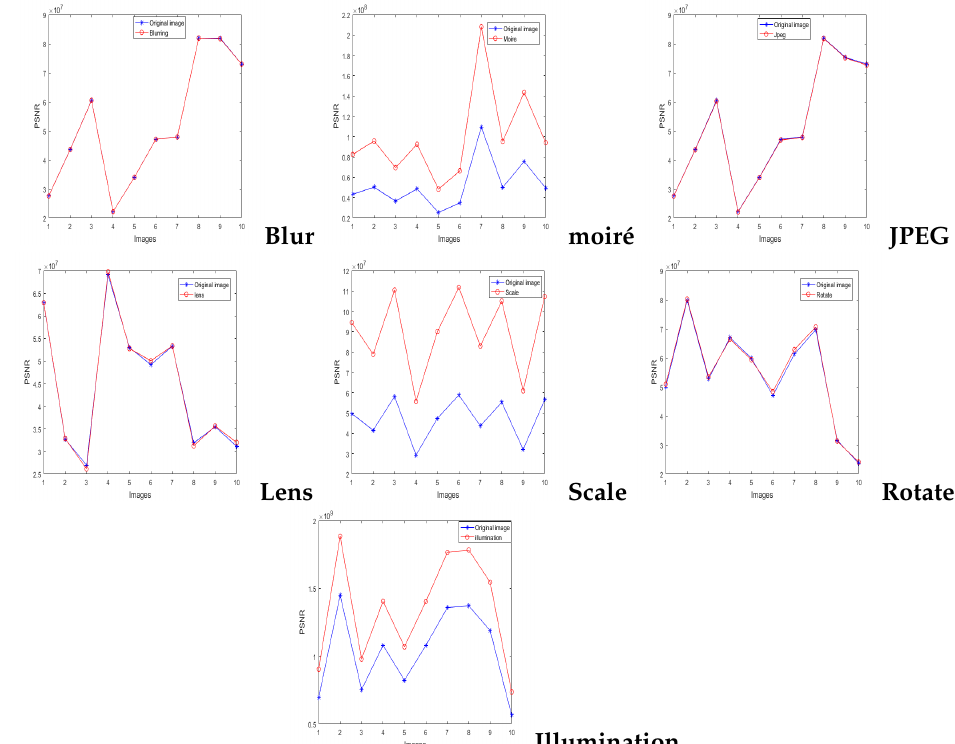
Figure 8. Value of core tensor K ( 1,1,1 ) resistance to different